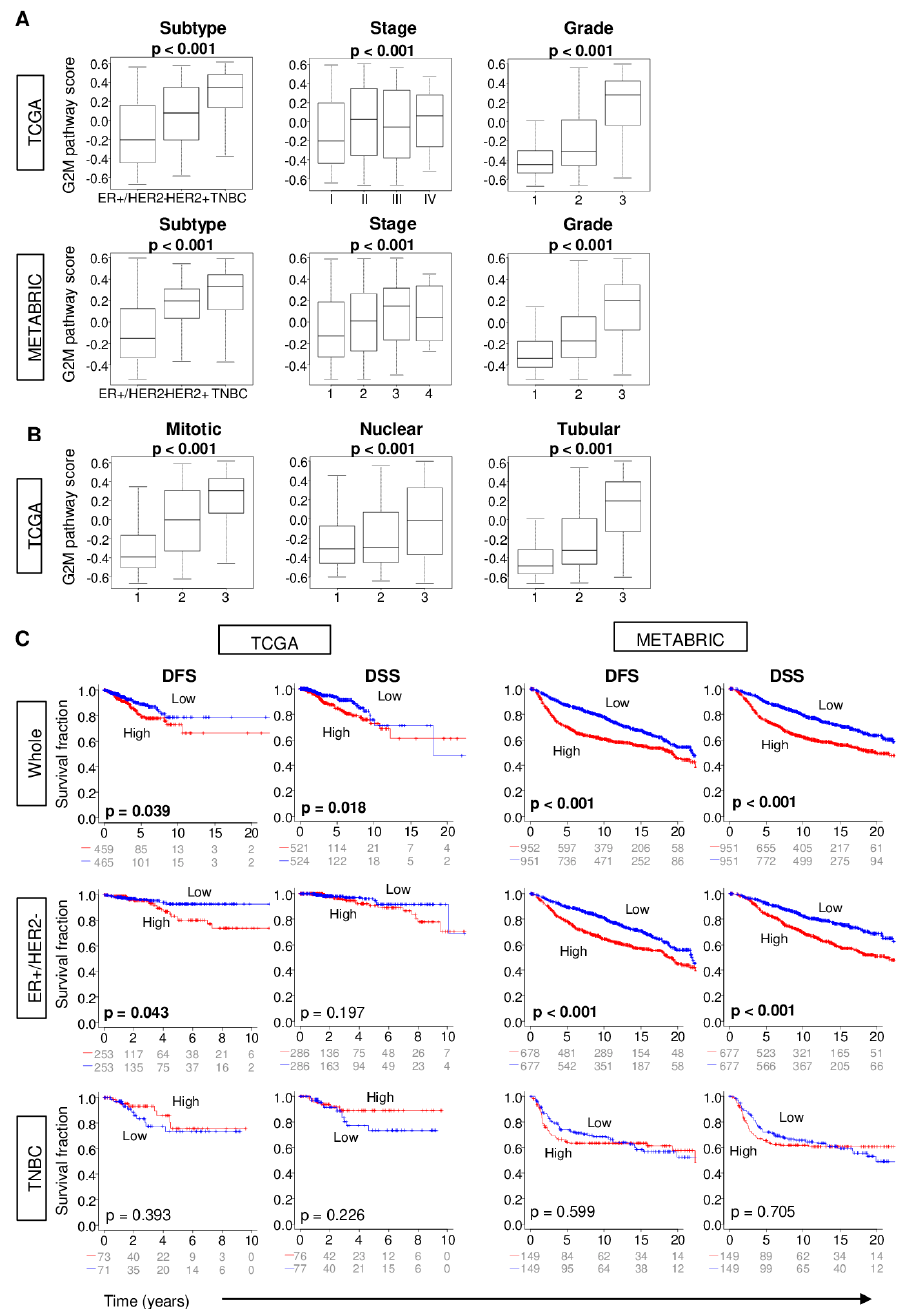
Figure 2. G2M pathway activity score and tumor characteristics and patient survival. ( A ). Tukey boxplots depict G2M scores among TCGA and METABRIC tumors of di ff erent grades, American Joint Committee on Cancer clinical stages, and subtypes. ( B ). Tukey boxplots depict G2M scores among TCGA tumors of di ff erent mitotic, nuclear, and tubular Nottingham histological scores. p -values for A and B are calculated using one-way analysis of variance ( ANOVA ). ( C ). Kaplan–Meier survival plots comparing patients with tumors with high and low G2M scores along with logrank test p -values are shown for disease-free ( DFS ) and disease-specific ( DSS ) survival for the entire cohort ( Whole ), or its sub-groups of estrogen receptor ( ER )-positive / human epidermal growth factor receptor ( HER2 )-negative and triple negative ( TNBC ) patients. The G2M score was calculated from tumor gene expression as the single-sample gene set variation analysis score for the Hallmark G2M gene set, and within-cohort median value was used to identify tumors with high and low